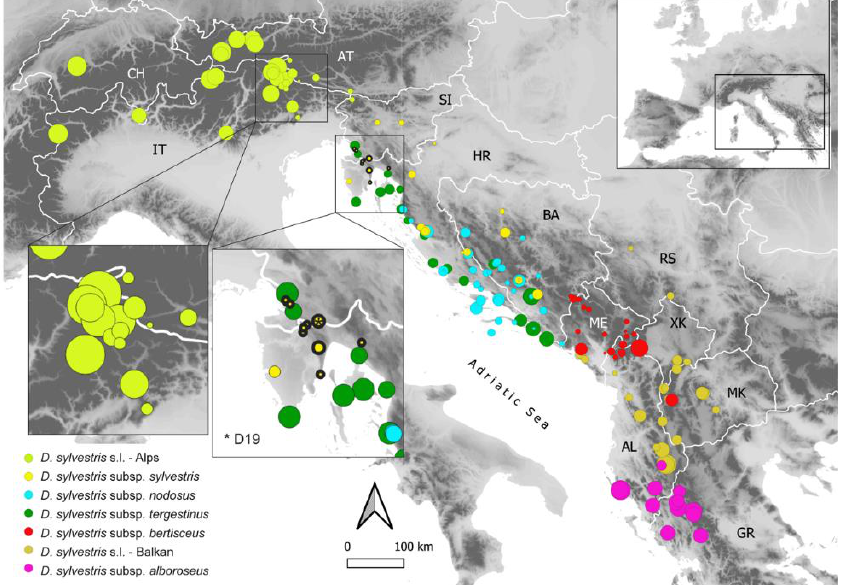
Figure 2. Geographical distribution of the monoploid relative genome size (RGS) variation of 162 diploid and tetraploid (circles with thick black outline) populations of Dianthus sylvestris s.l. in the Balkan Peninsula and the Alps. Only populations with at least three measured individuals and a standard deviation of RGS < 0.01 are shown. The size of the dots is proportional to the mean monoploid RGS of the corresponding populations. Asterisk indicates the ploidy-mixed population D19. Color coding indicates different taxa.